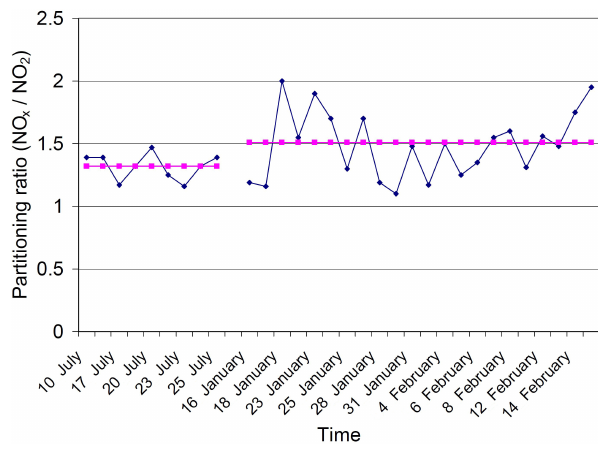
Figure A3. Partitioning ratios derived from the model simulations for the locations of the maximum NO 2 VCDs for all days of the campaigns. A large day-to-day fluctuation but also a systematic dif- ference between winter and summer is found. The average ratios for summer and winter are 1.32 and 1.51, respectively.